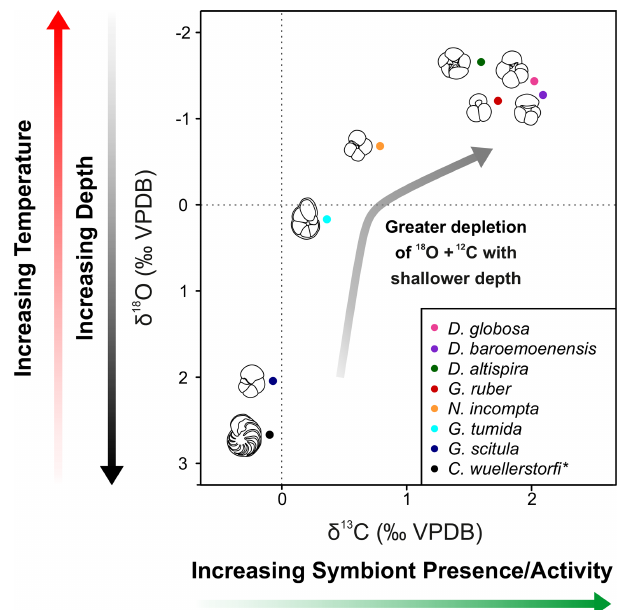
Figure 4. δ 13 C and δ 18 O cross-plot 2 showing mean values of all specimens analyzed in this study. Black = C. wuellerstorfi , dark blue = G. scitula , cyan = G. tumida , orange = N. incompta , red = G. ruber , green = D. altispira , purple = D. baroemoenensis , pink = D. globosa. Species marked with an asterisk are benthic.